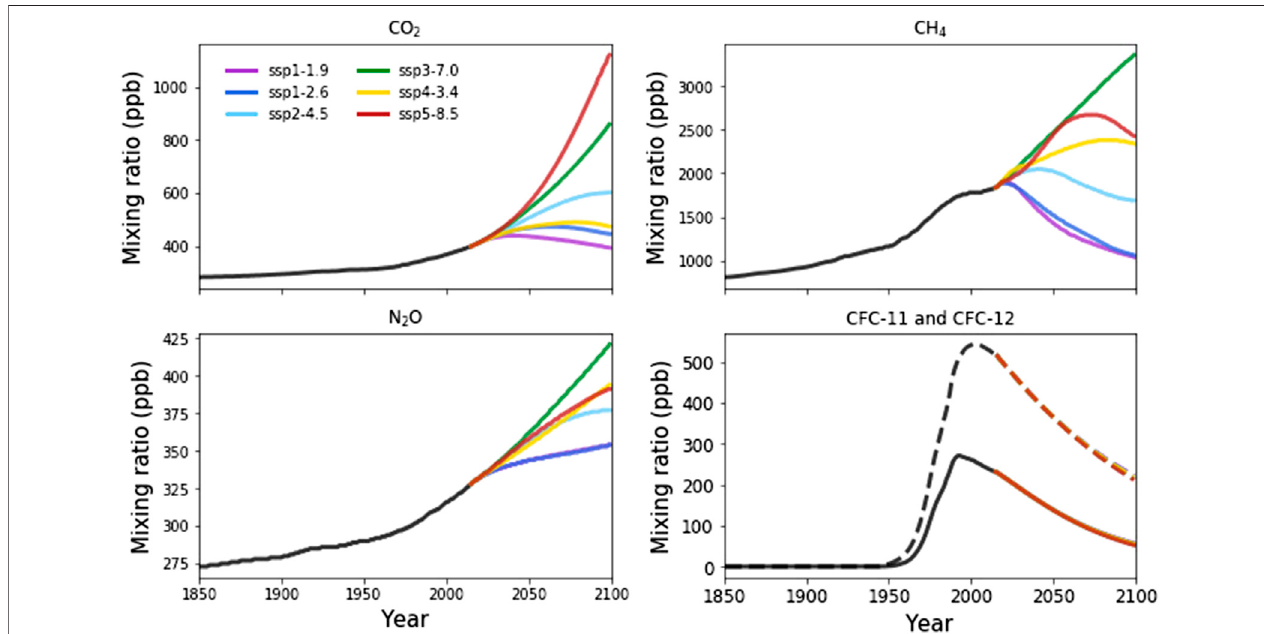
FIGURE 1 | Evolution of CO 2 , CH 4 , N 2 O, CFC-11 and CFC-12 surface mixing ratios throughout the historical period (1850 – 2014; black) and projected into the future under the Shared Socioeconomic Pathways (2014 – 2100; colored lines). For the CFC panel, CFC-11 is shown in the solid lines and CFC-12 in the dashed lines.